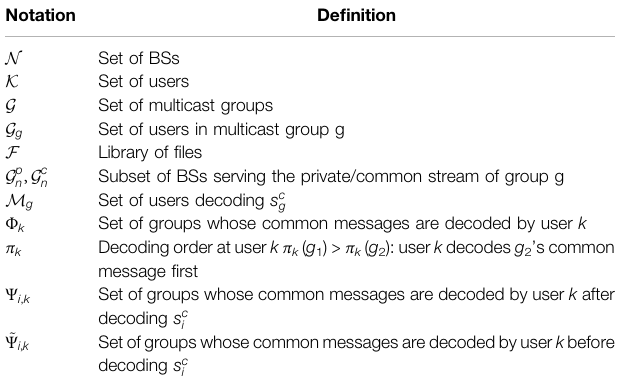
TABLE 1 | List of mathematical notations.